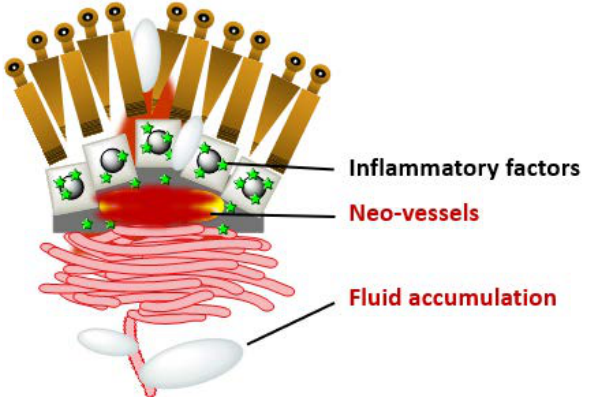
Figure 10. Current therapeutic targets for the treatment of exudative AMD.